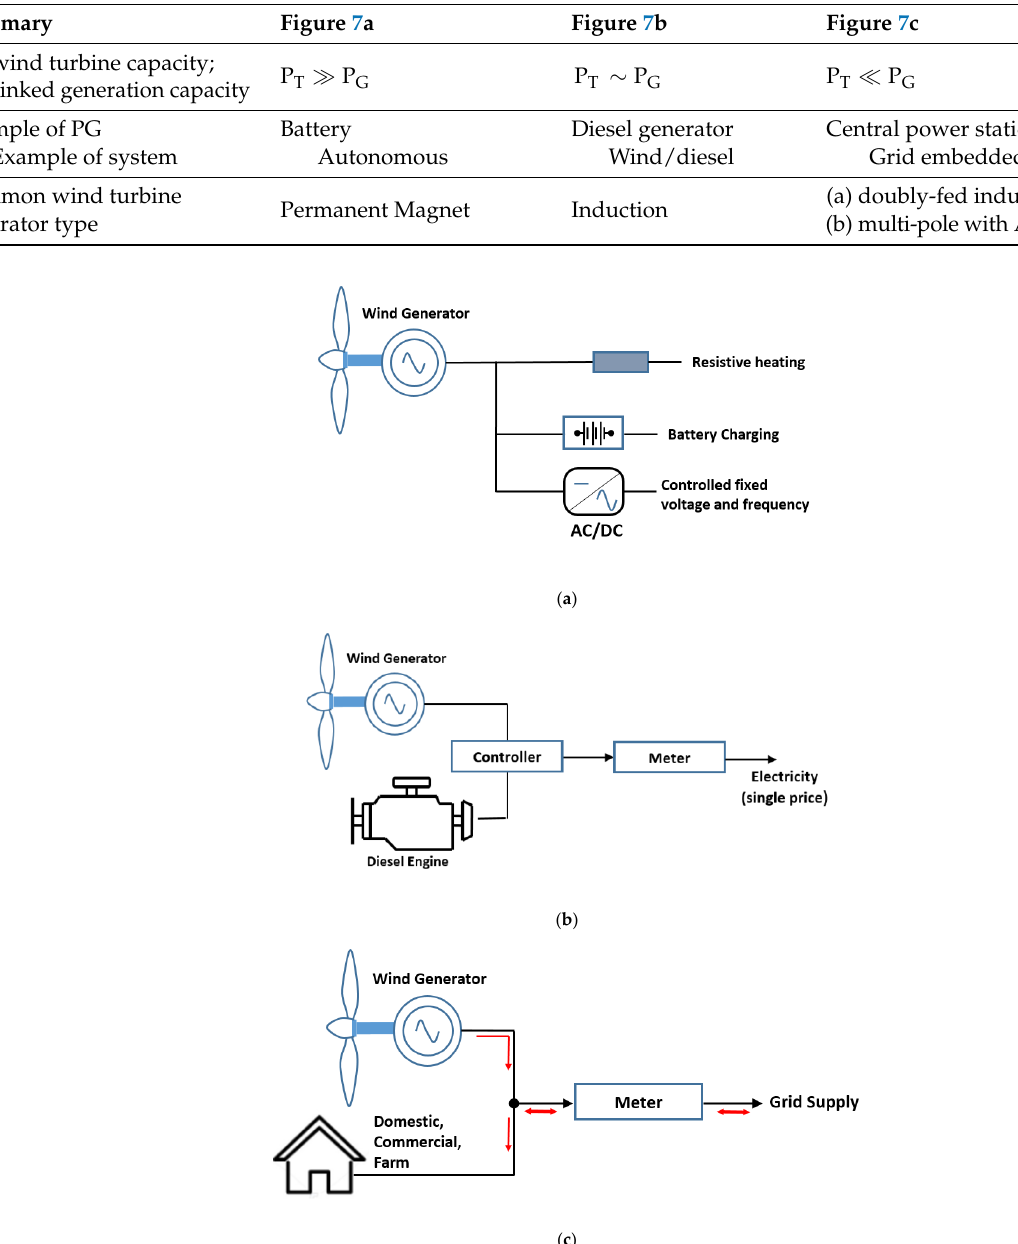
Table 2. A classification of wind turbine electricity systems.